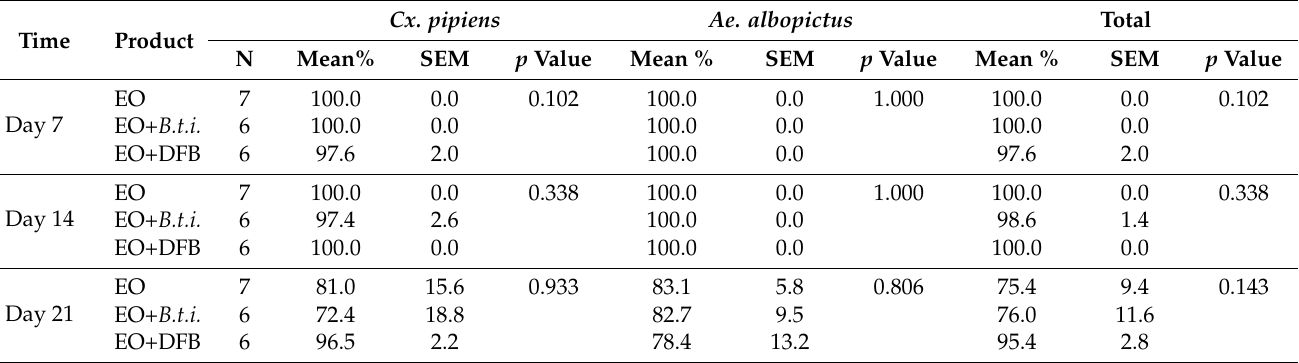
Table 1. Mean % of immature population reduction (corrected using Mulla’s formula) (+/ − SEM) of Cx. pipiens and Ae. albopictus at 7, 14, and 21 days post-treatment with oregano essential oil (EO), oregano essential oil + diflubenzuron (EO+DFB), and oregano essential oil + B.t.i. (EO+ B.t.i. ) in road drains in Crevalcore, Italy, during July